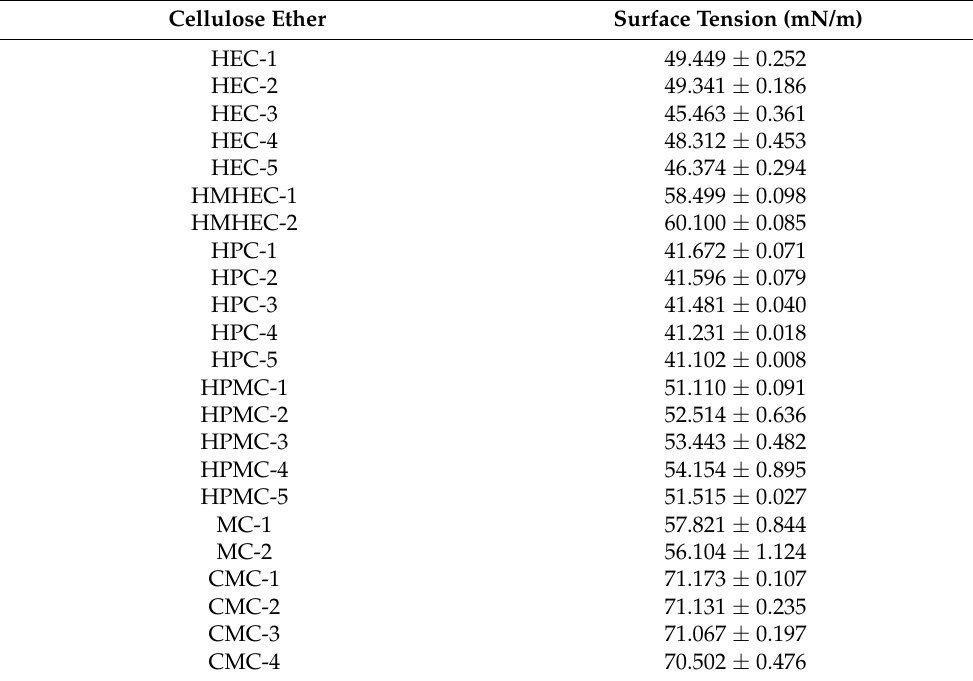
Table 6. Surface tension data of 0.1% ( w / w ) solutions of the cellulose ethers at 22.0 ◦ C. Cellulose